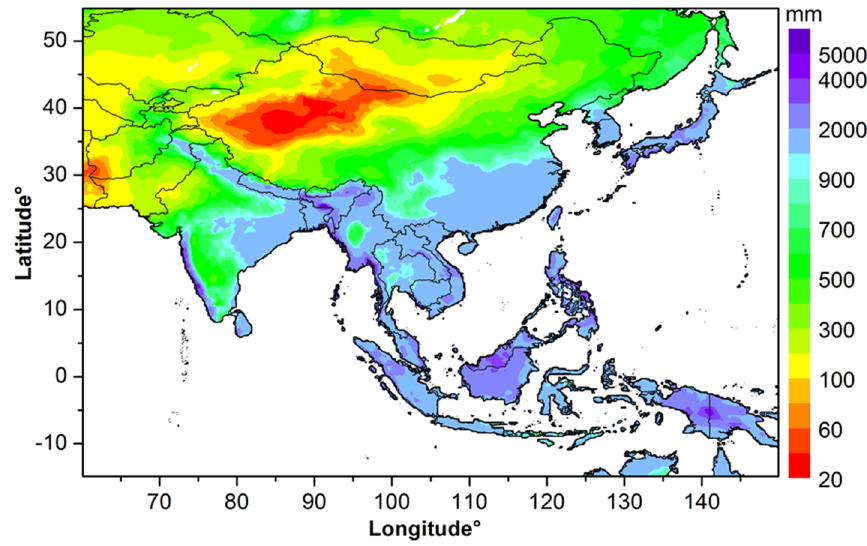
Figure 1. Spatial distribution of mean annual rainfall (1998–2015) over monsoon Asia